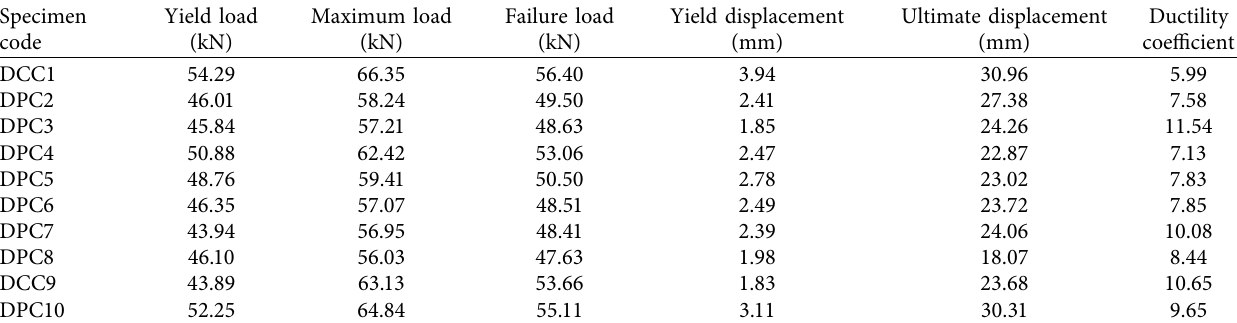
Figure 14: Load-displacement curves. (a) DCC1 and DCC9. (b) DCC2 and DCC10. (c) Equivalent area ratio as a variable. (d) Grouting strength as a variable. (e) Assembly area length as a variable. Table 5: Simulation results of the specimens.